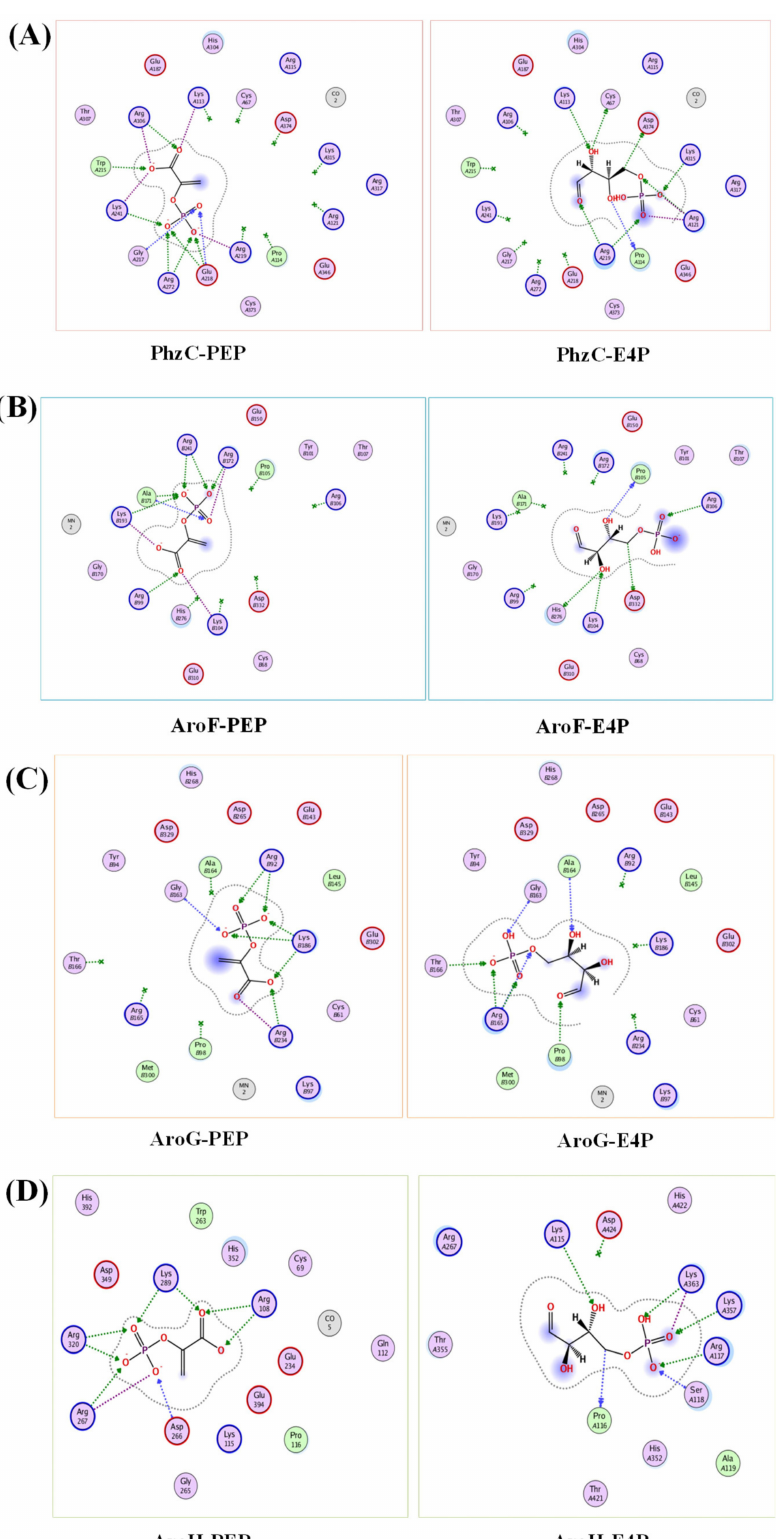
Figure 9. Molecular docking of DAHP synthases in P . chlororaphis . Analysis of the binding mode of PEP and E4P with PhzC ( A ), AroF ( B ), AroG ( C ), AroH ( D